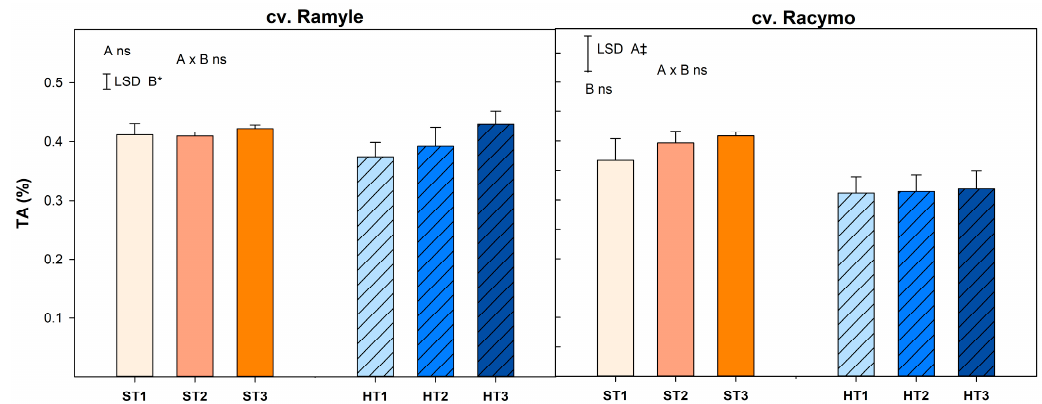
Figure 2. Titratable acidity (TA) of two tomatoes (cvs. Ramyle and cv. Racymo) under di ff erent irrigation treatments (T1: desalinated seawater with low electrical conductivity (EC); T2: well / desalinated water, intermediate EC; and T3: well water with high EC) and cultivation systems (traditional soil system, S; hydroponic, H) ( n = 3 ± SD). The uppercase letters A and B denote cultivation system and irrigation treatment, respectively. ns, *, and ‡ significance for p ≤ not significant, 0.05, and 0.001, respectively.